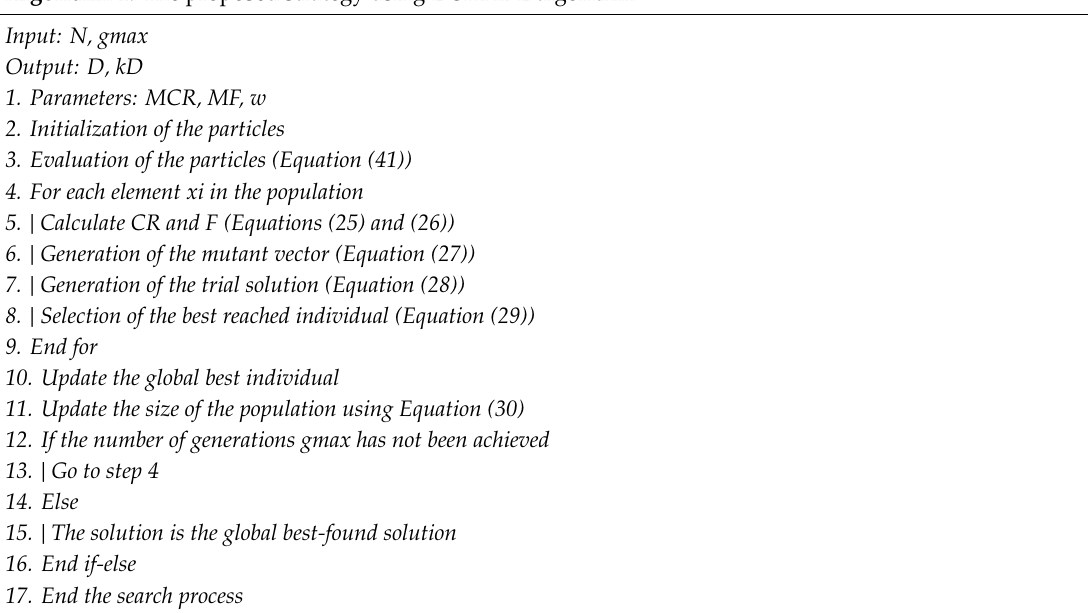
Algorithm 1. The proposed strategy using L-SHADE